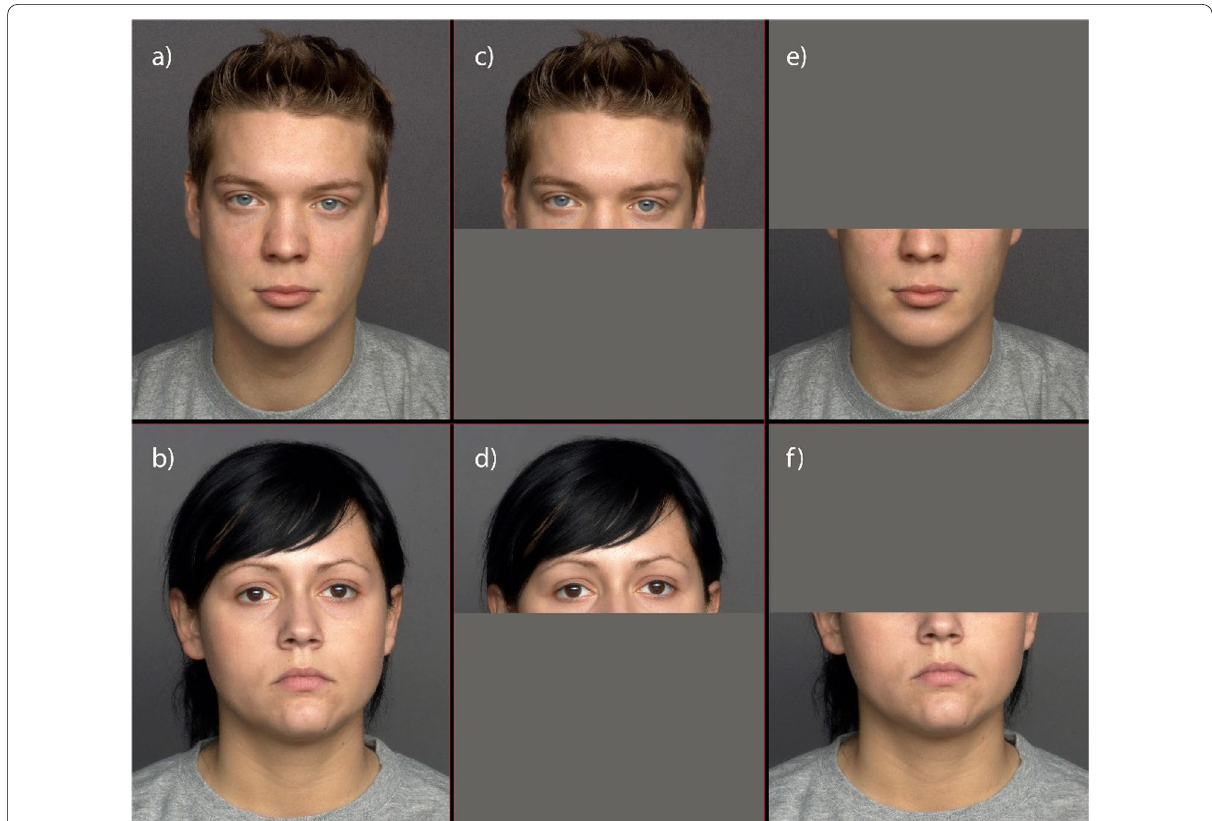
Fig. 5 Examples of full ( a and b ), and upper half male and female faces ( c and d ) used in Study 3; examples of full ( a and b ) and lower half faces ( e and f ) used in Study